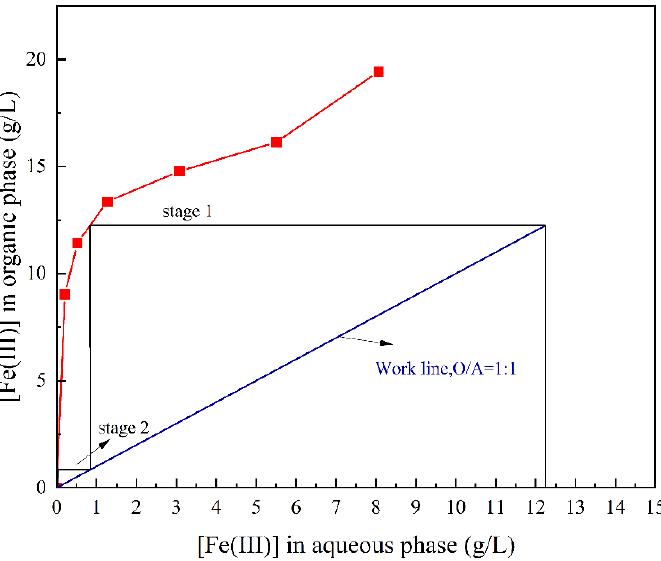
Figure 8. McCabe-Thiele extraction equilibrium isotherms of Fe 3+ under the conditions: room temperature (298 K), [D2EHPA] = 1 mol/L, initial [Fe 3+ ] = 12.25 g/L, extraction time = 20 min, saponification rate = 70%, and initial pH = 1.00.